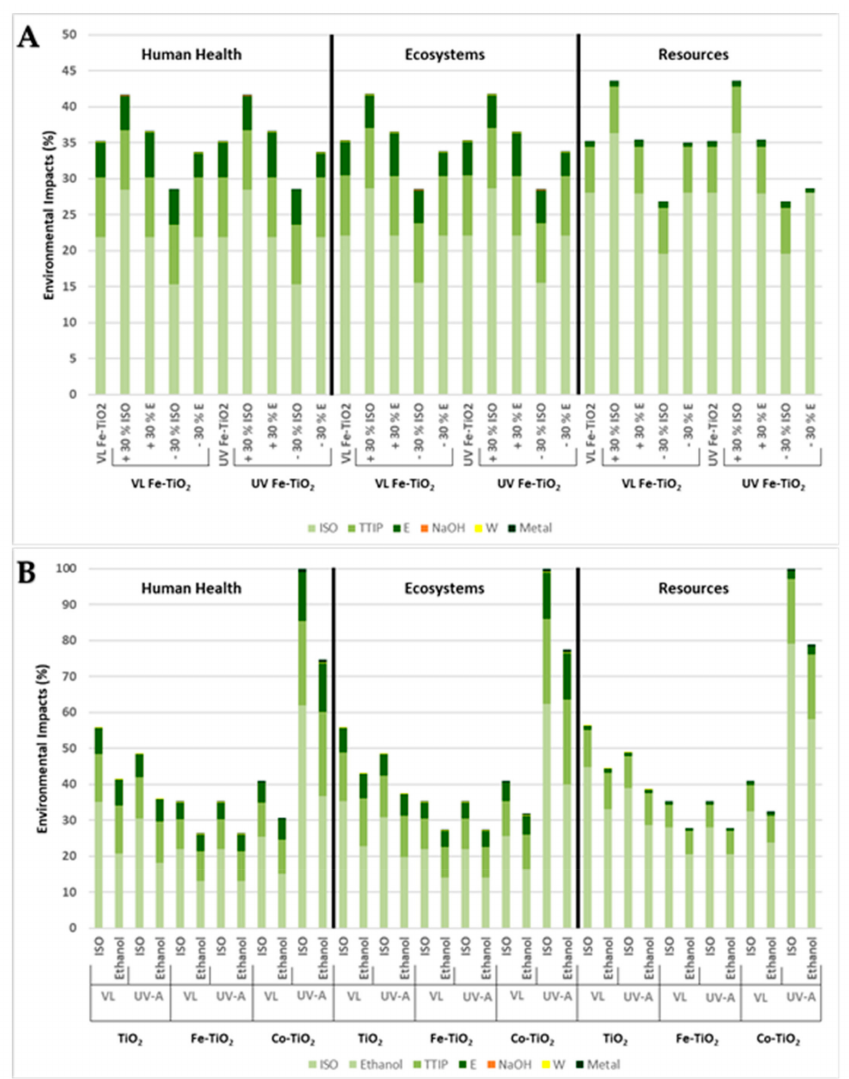
Figure 5. Relative environmental impacts for sensitivity analysis of Fe–TiO 2 photocatalyst ( A ) and comparison of the substitution of ISO with Ethanol ( B ) in CBZ degradation, under either UV-A or visible-light (VL)